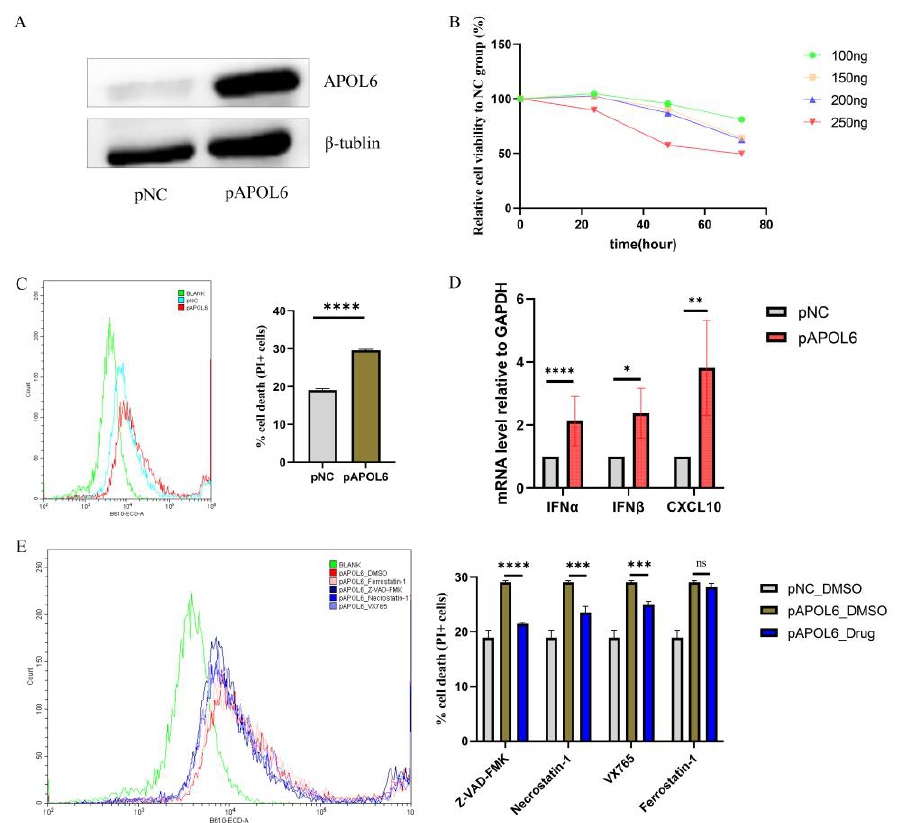
Figure 5. APOL6 induced immunogenic cell death in vitro. ( A ) Immunoblot analysis of FLAG-tagged APOL6 expression in transfected MIA PaCa-2 cells. ( B ) Cell viability of APOL6-transfected MIA PaCa-2 cells was determined using CCK8 assay. MIA PaCa-2 cells were seeded in 96-well plates and transfected with various doses of APOL6 overexpression plasmid for the indicated time-points. The APOL6 protein amount in MIA PaCa-2 cells transfected with APOL6 expression plasmids at different doses was shown in Figure S2. ( C ) Cell death of APOL6-transfected MIA PaCa-2 cells was detected with PI staining by flow cytometry. ( D ) The expression of cytokines and chemokines involved in type I interferon response was measured by qRT-PCR. ( E ) APOL6-transfected MIA PaCa-2 cells were treated with Z-VAD-FMK (10 µ M) [23], necrostatin-1 (10 µ M) [23], VX765 (10 µ M) [22]